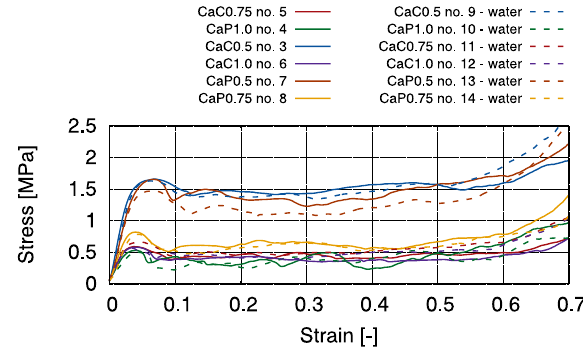
Figure 6. Stress-strain diagram of all tested speci- mens. Dry specimens are shown in solid and specimens immersed in water as dashed